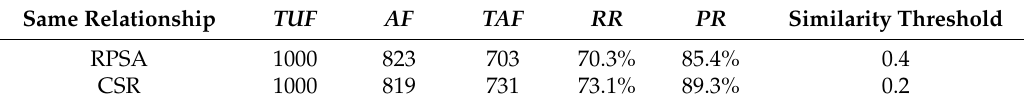
Table 1. The RR s and PR s when we use these test webpages.